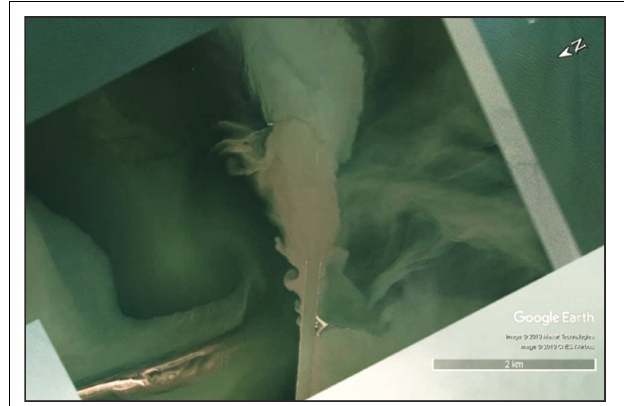
FIGURE 6 | Straight jet of Sulina (Danube) river mouth (channelized by jetties), used to show similarities with modeled straight jets. Satellite image from Google Earth.